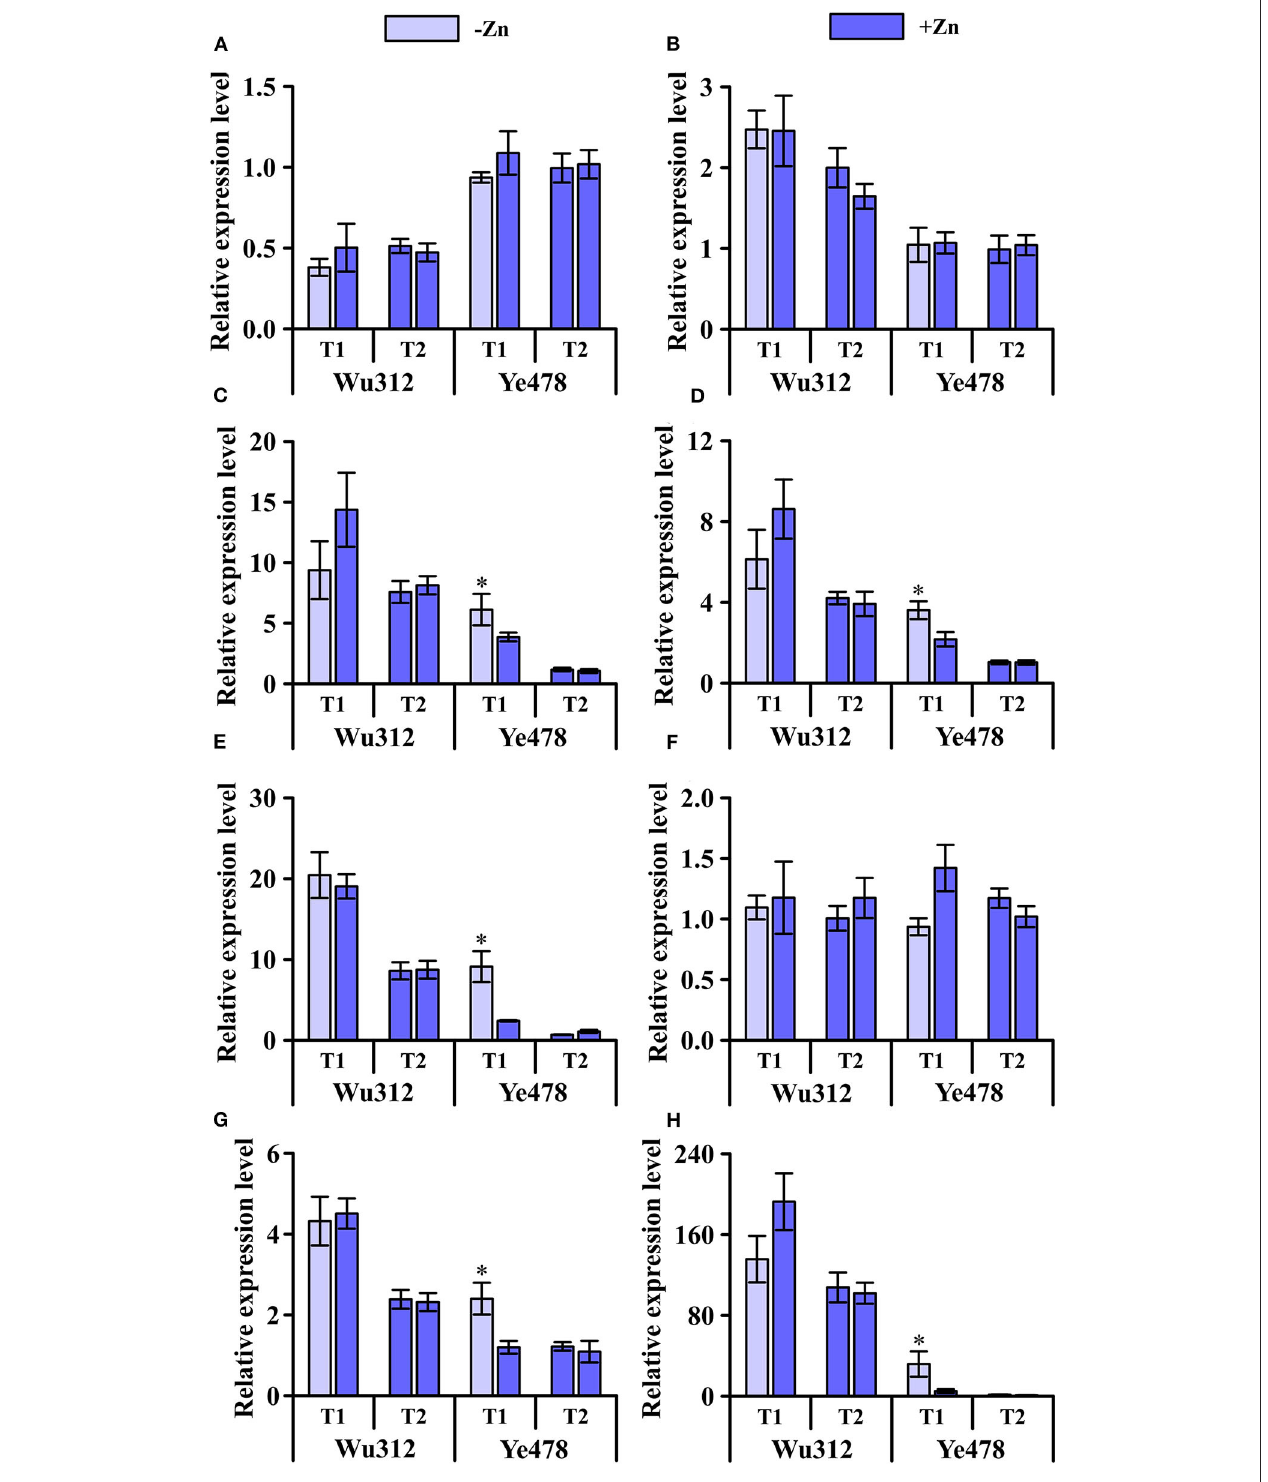
FIGURE 7 | Expression of ZmZIP1 (A) , ZmZIP2 (B) , ZmZIP3 (C) , ZmZIP4 (D) , ZmZIP5 (E) , ZmZIP6 (F) , ZmZIP7 (G) , and ZmZIP8 (H) genes in the roots of Zn-sensitive inbred line Wu312 and Zn-tolerant inbred line Ye478 under split-supply with –Zn (0.5 µ M) and + Zn (8 µ M) (T1 treatment) and with + Zn (8 µ M) and + Zn (8 µ M) (T2 treatment) in Experiment 3. *Indicate significant difference between the –Zn ( + Zn) region and + Zn ( + Zn) region in T1 (T2) treatment at p < 0.05.